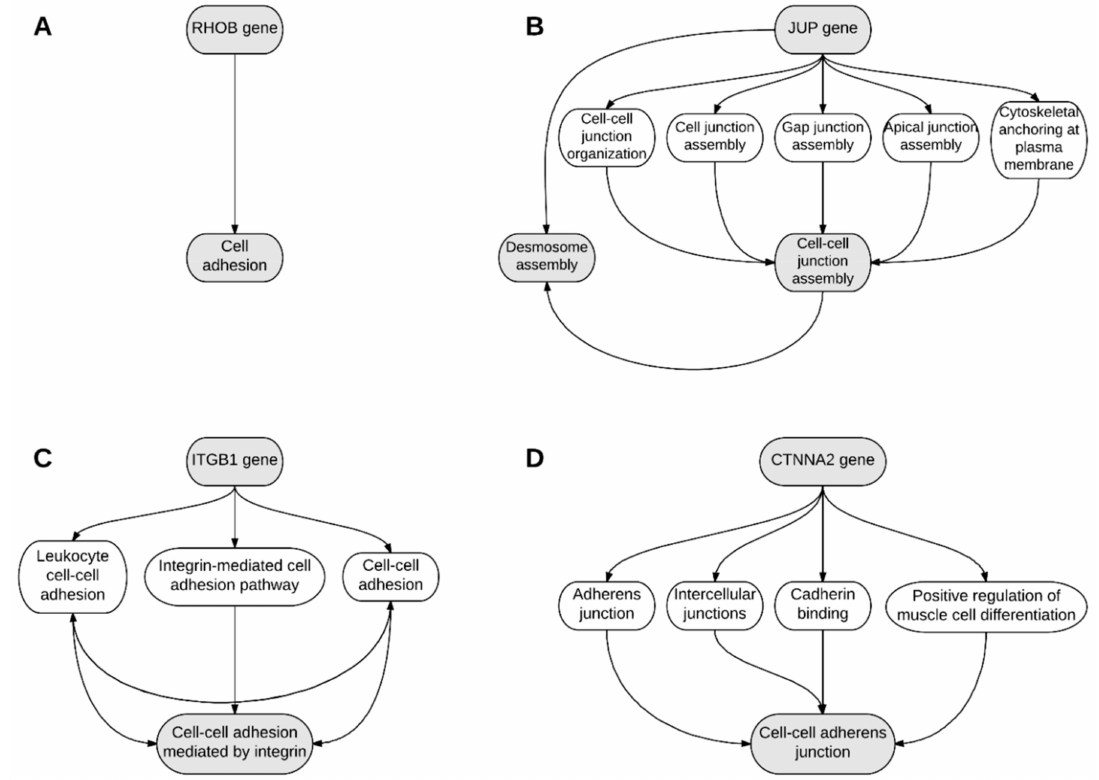
Figure 4. BioGraph results showing known interaction that connect the role of ( A ) RHOB gene in cell adhesion, ( B ) JUP gene in desmosome assembly, ( C ) ITGB1 gene in cell–cell adhesion mediated by integrin, and ( D ) CTNNA2 gene in cell to cell adherent